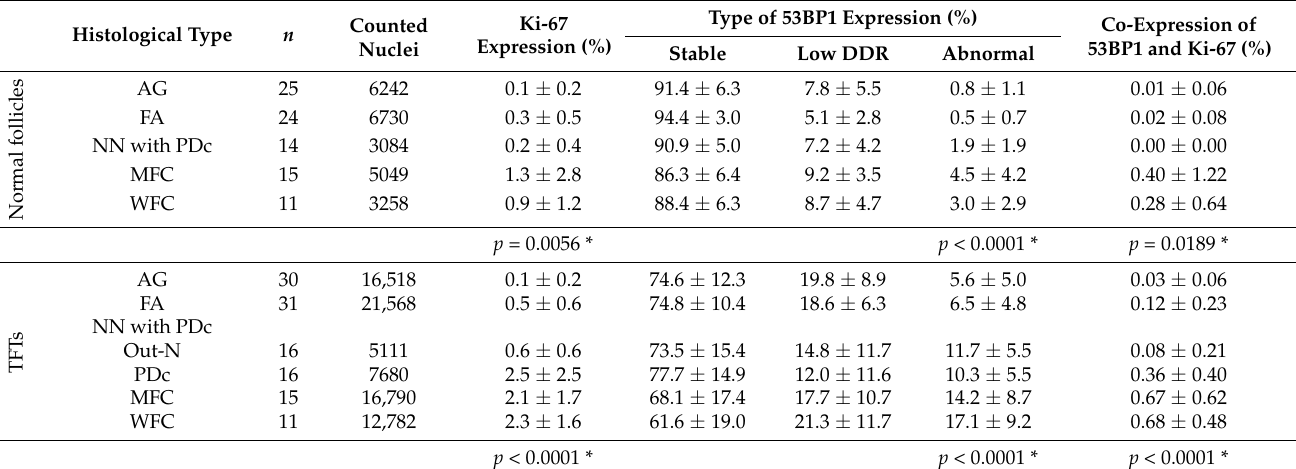
(Table 2). The co-localization of 53BP1 nuclear expression with Ki-67 in normal follicles was significantly associated with the histological type of TFTs ( p = 0.0189). Table 2. Types of TP53-binding protein 1 (53BP1) in thyroid follicular-patterned tumors (TFTs) identified by immunofluorescence.